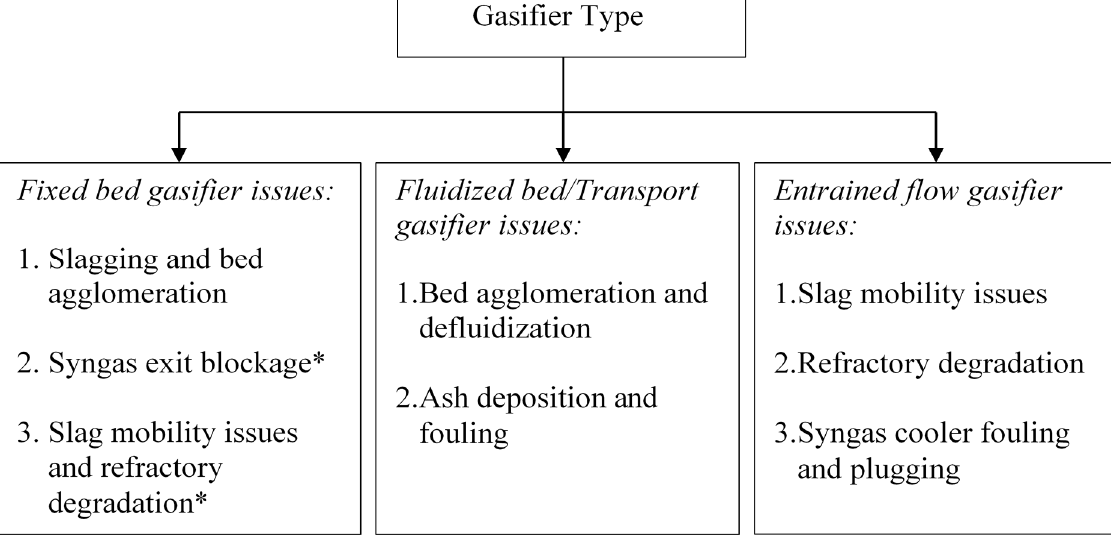
Figure 1. Operation related issues due to mineral matter in various types of gasifiers (* specific to slagging fixed bed